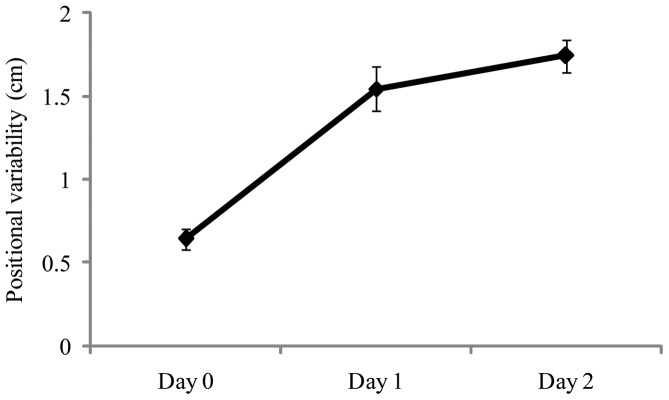
Experiment 2: Mean positional variability of the COP as a function of days.The figure illustrates the statistically significant effect of days. The error bars represent standard error of the mean.